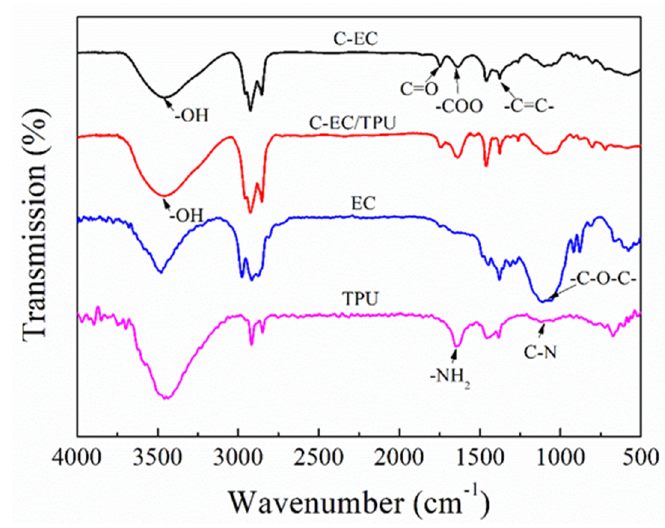
Figure 3. FT-IR spectra of C-EC and C-EC/TPU.